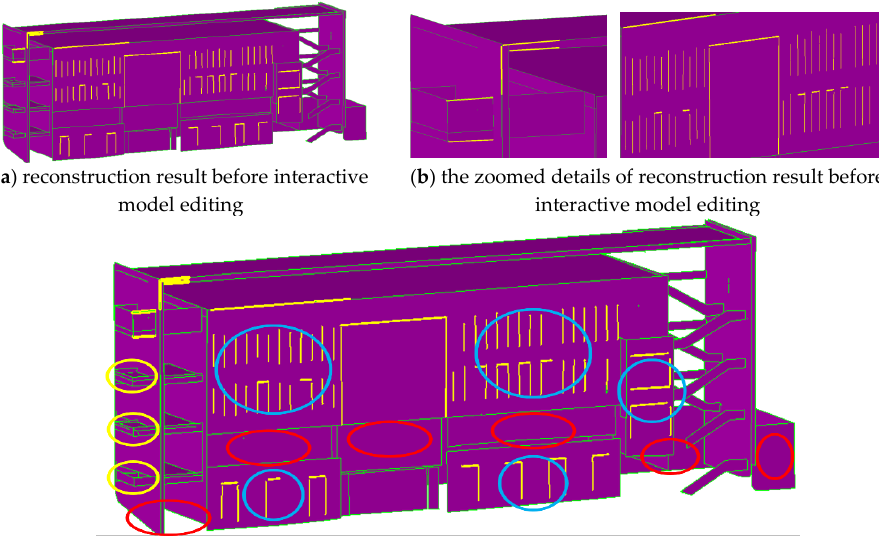
Figure 12. Results of line feature matching and projection the forward intersected lines to corresponding segmented planes.